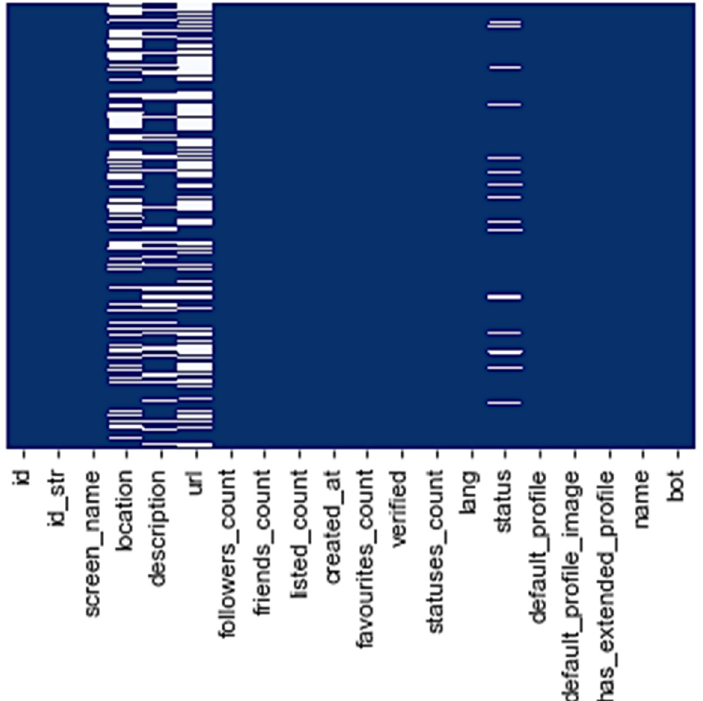
Figure 2. Analysis of Missingness in Bots Dataset.